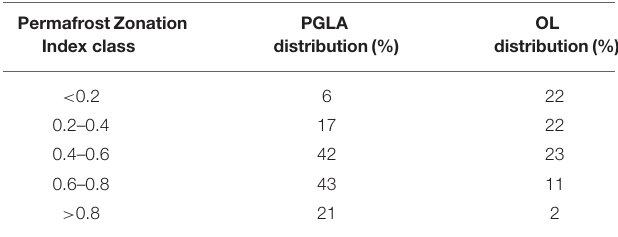
TABLE 6 | Distribution of peri/pro glacial lakes away from glaciers (PGLA) and other lakes (OL) in different sub-classes of Permafrost Zonation Index (PZI) in the Sikkim